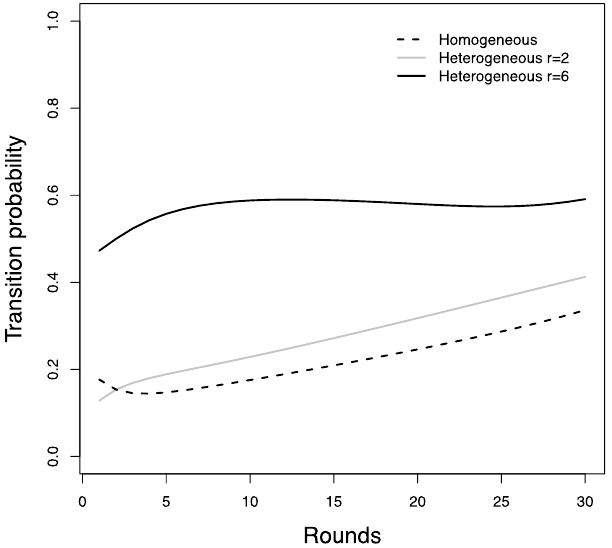
Figure 5. Probability flux towards the Nash equilibrium state. The flux of probability towards the Nash equilibrium state L 0 in rounds with r = 2 in both treatments increases as more rounds are played. The flux towards the Nash equilibrium state L 5 in rounds with r = 6 in the heterogeneous treatment changes